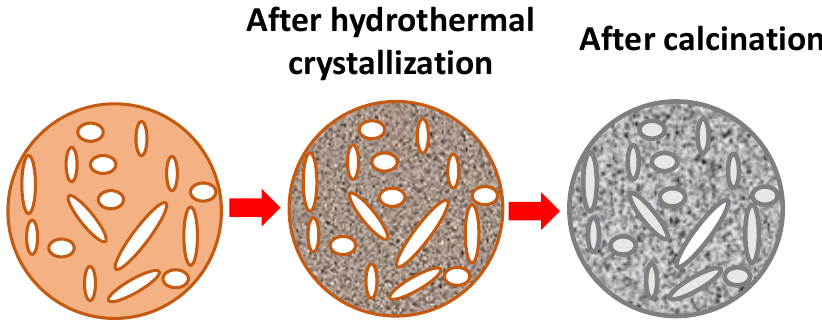
Figure 3. Synthesis of bead shape silicalite-1 using resin beads as hard templates.